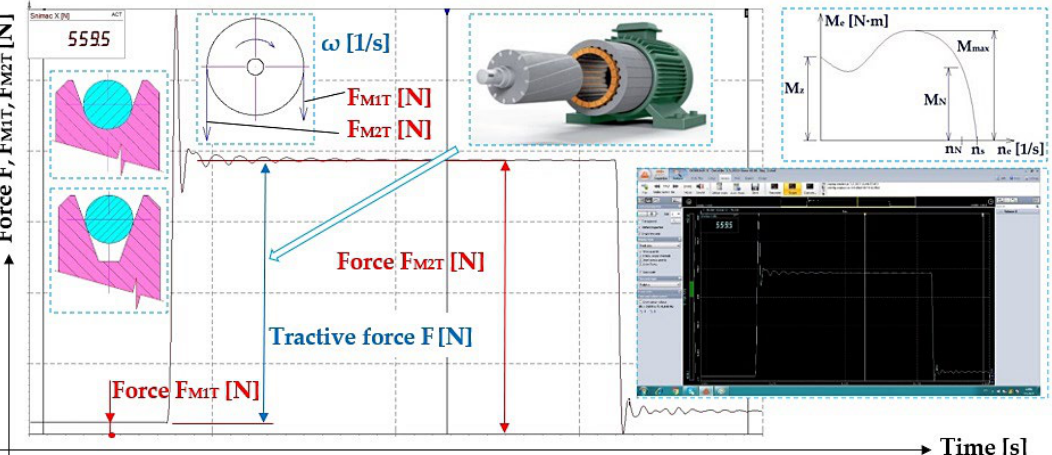
Figure 3. Measurement of tensile force F M2T [N] in the approaching side of the rope on the sheave at the moment of starting the drive unit.